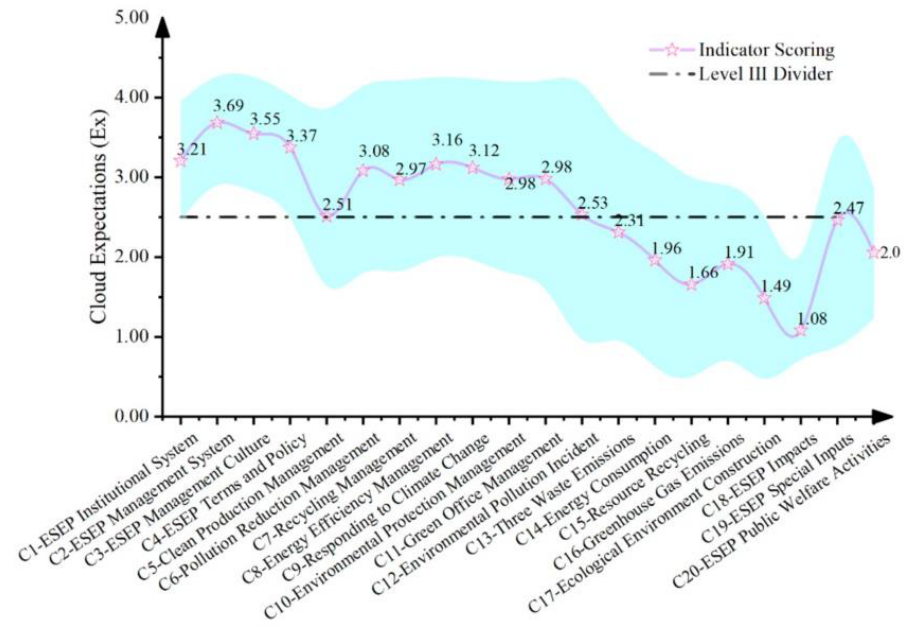
Figure 8. Expected value of each index cloud